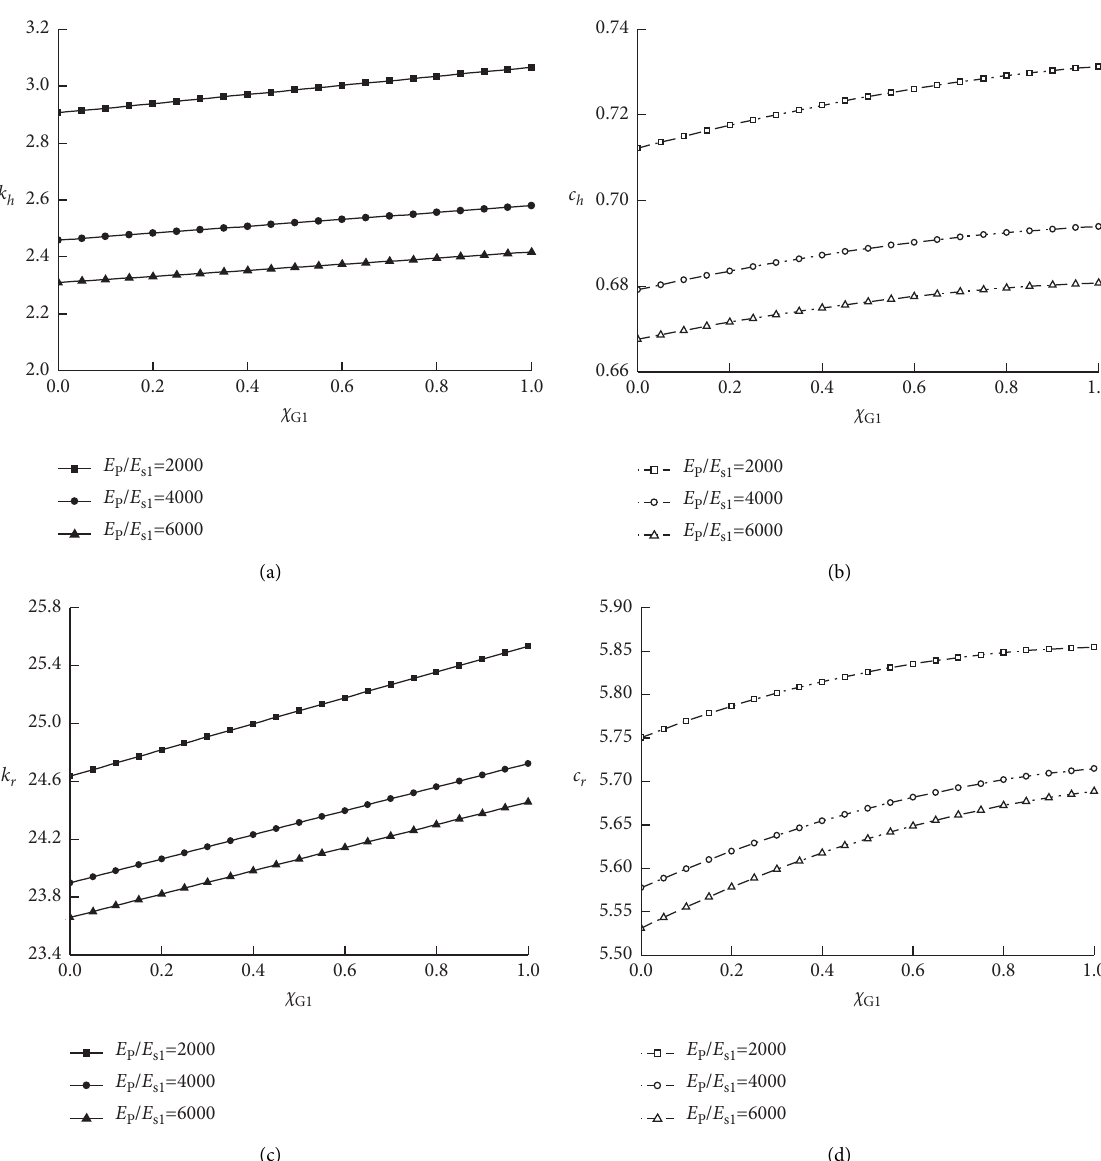
Figure 7: Effects of the soil shear effect and topsoil elastic modulus ratio change on the pile top complex impedance. (a) Horizontal dimensionless dynamic stiffness. (b) Horizontal dimensionless dynamic damping. (c) Sway dimensionless dynamic stiffness. (d) Sway dimensionless dynamic